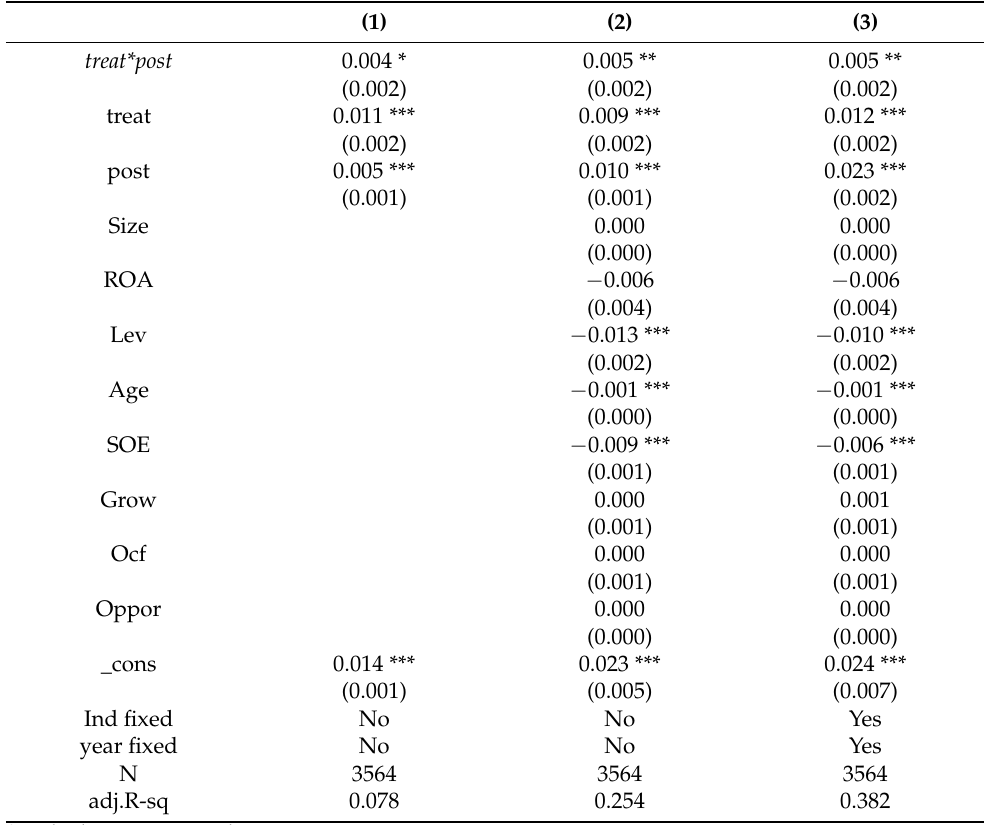
Table 9. The estimation results of redefining the dependent